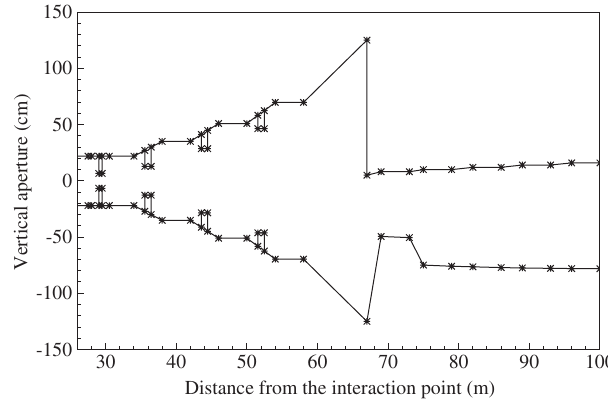
FIG. 19. Vertical apertures seen by the disrupted beam and the same-sign charged particles of the coherent pairs.